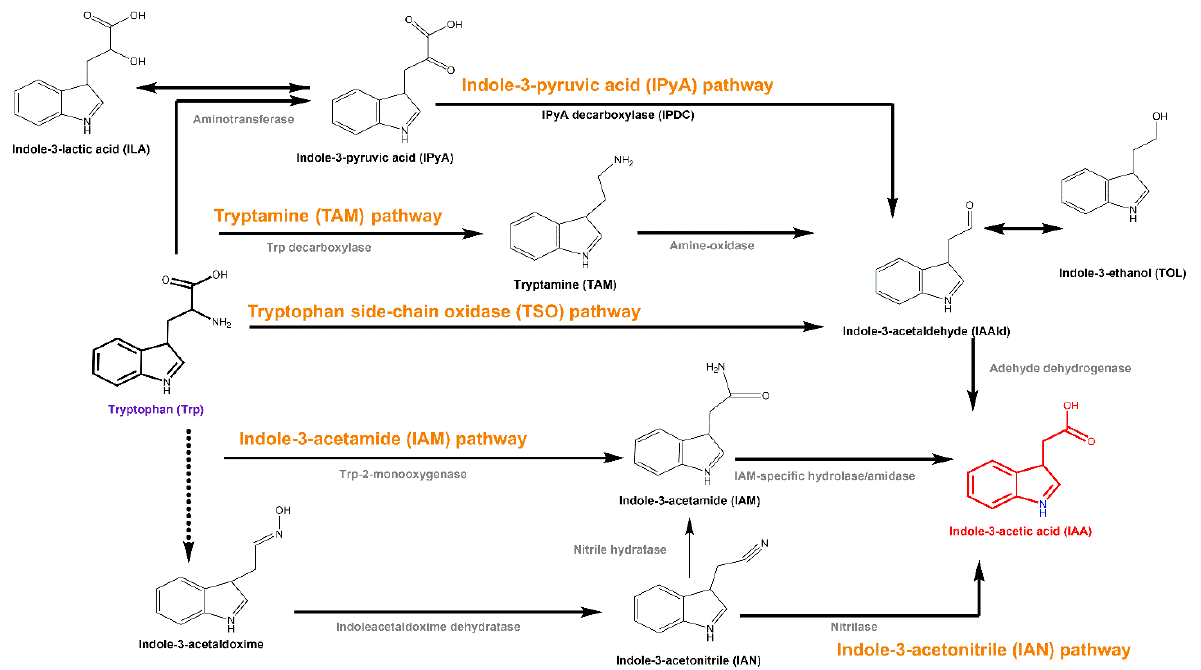
Figure 1. Tryptophan-dependent biosynthesis pathways. Trp: tryptophan; IAA: indole-3-acetic acid; IAM: indole-3-acetamide; IAN: indole-3-acetonitrile; TAM: tryptamine; IPyA: indole-3-pyruvic acid; ILA: indole-3-lactic acid; IAAld: indole-3-acetaldehyde; TOL: indole-3-ethanol.